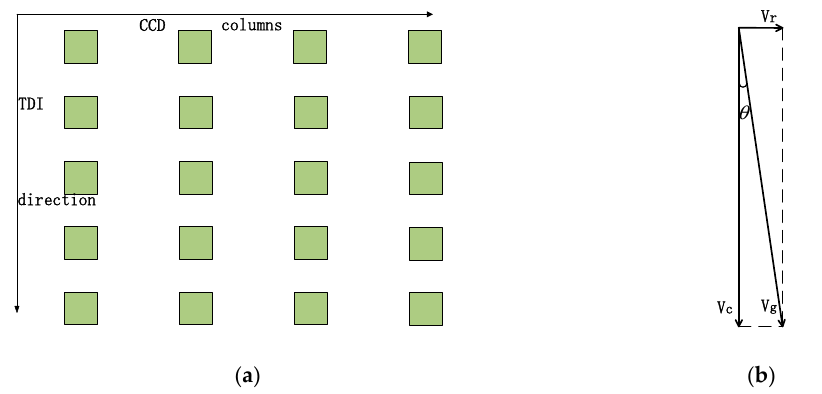
Figure 5. Schematic of time delay integration (TDI)–CCD. ( a ) Operation mode of TDI-CCD; ( b ) The relationship between each velocity.